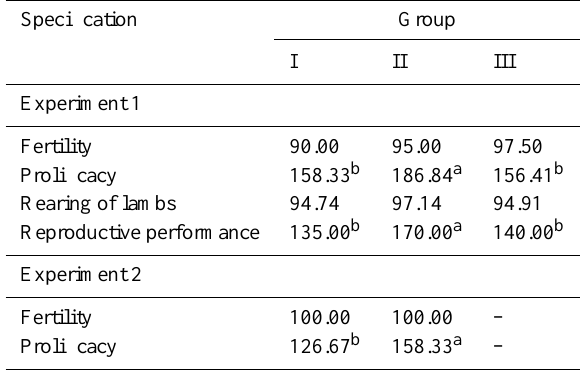
Table 1. Results of the breeding performance of the ewes.